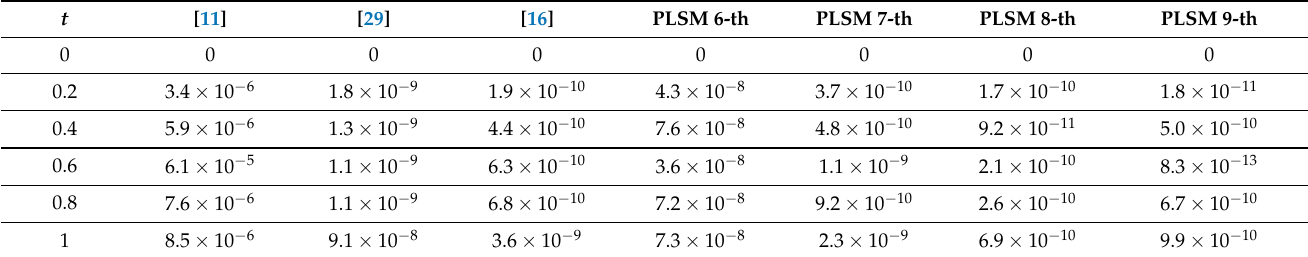
Table 3. Comparison of the absolute errors of the approximate solutions for problem (24) corresponding to α = 1.